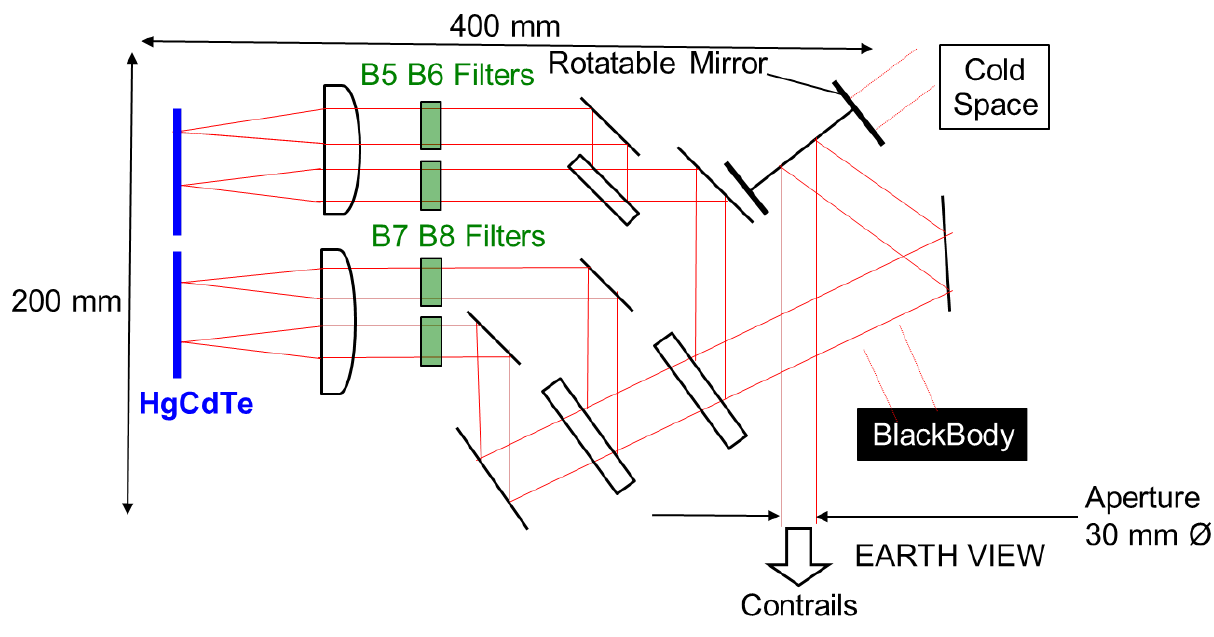
Figure 10. MIR/TIR optical system